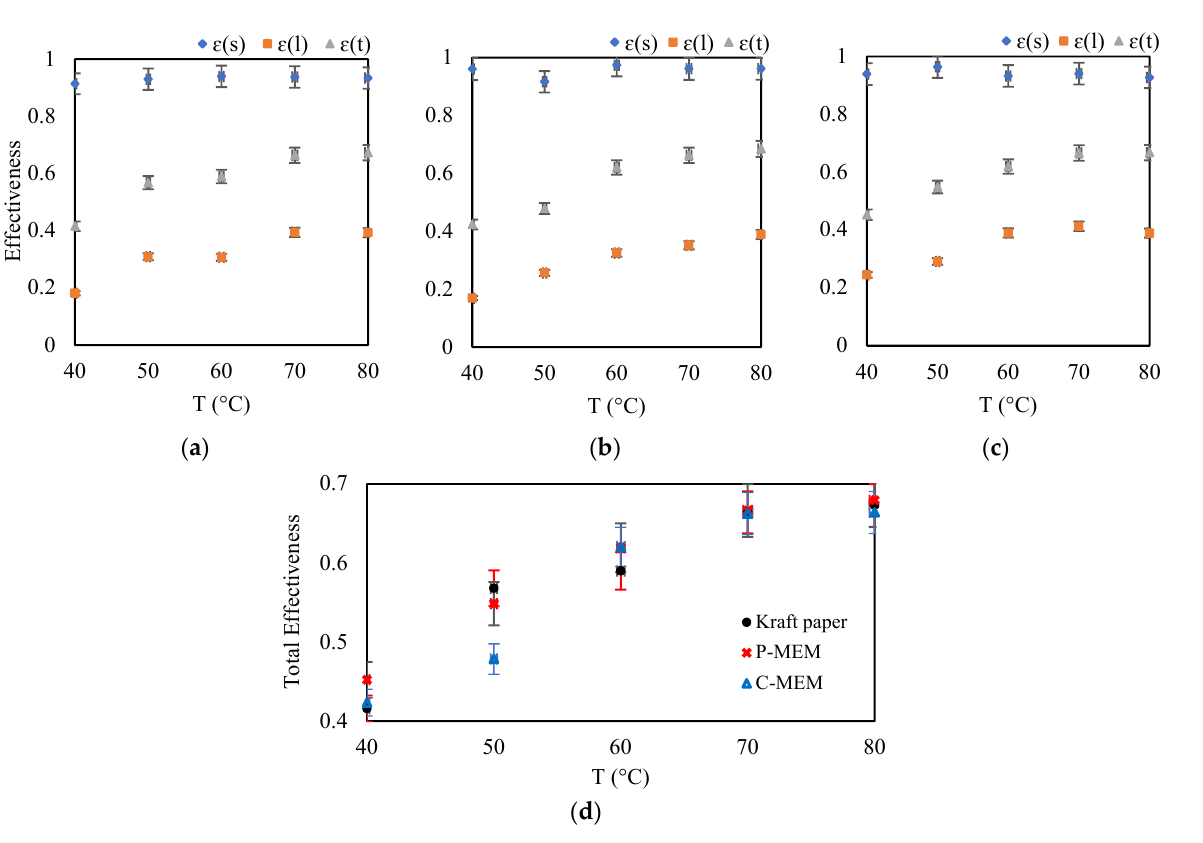
Figure 6. Effect of increasing the incoming humid air temperature on sensible, latent, total effective- ness for ( a ) kraft paper, ( b ) C-MEM, and ( c ) P-MEM, and ( d ) comparison of the total effectiveness of different membranes at different incoming humid air temperatures.